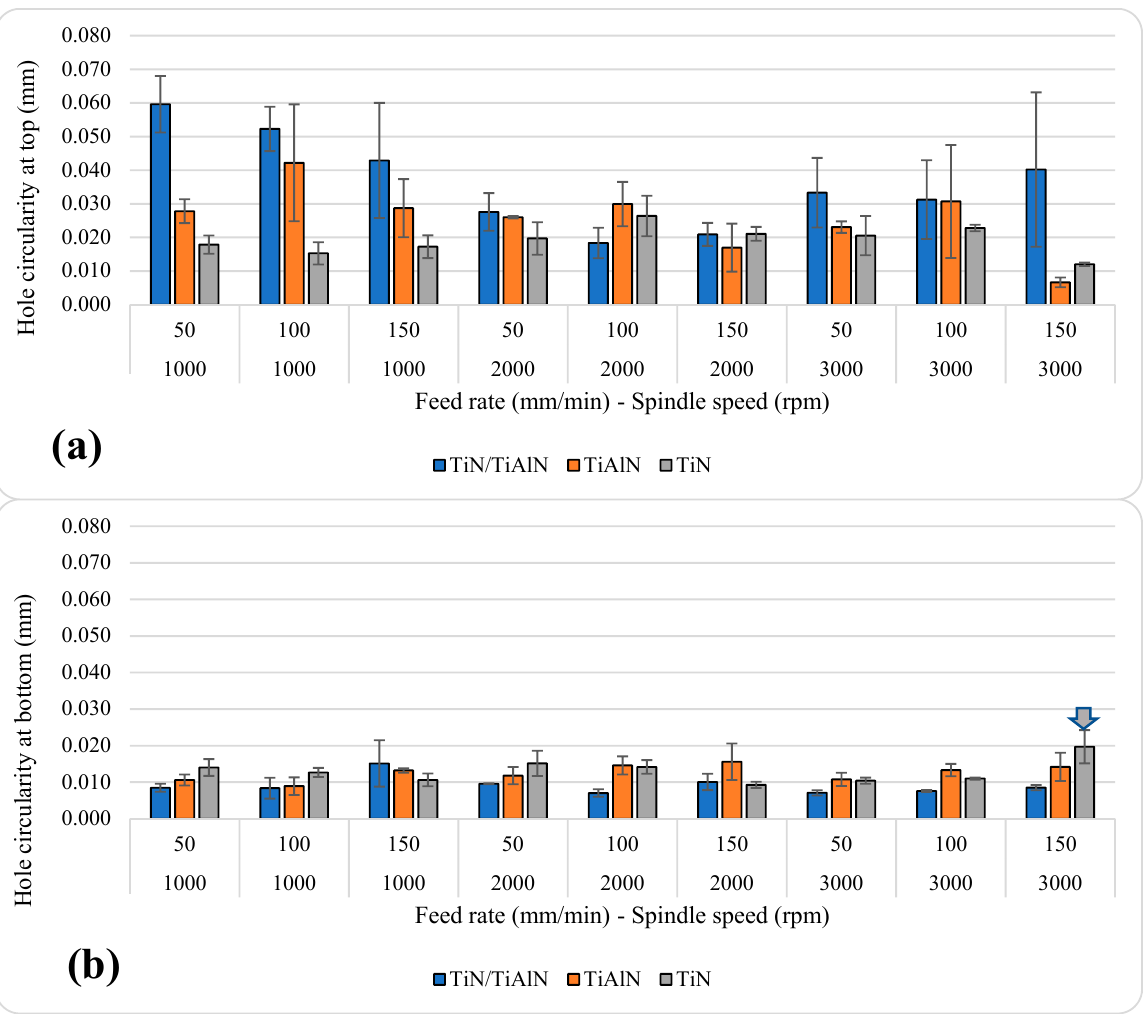
Figure 9. Average hole circularity errors: ( a ) at the top of the hole; ( b ) at the bottom of the hole.